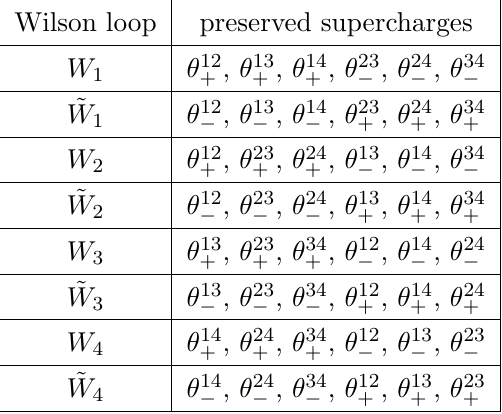
Table 2. The 1/2 BPS WLs in ABJM theory and the preserved Poincar(cid:19)e supercharges. We